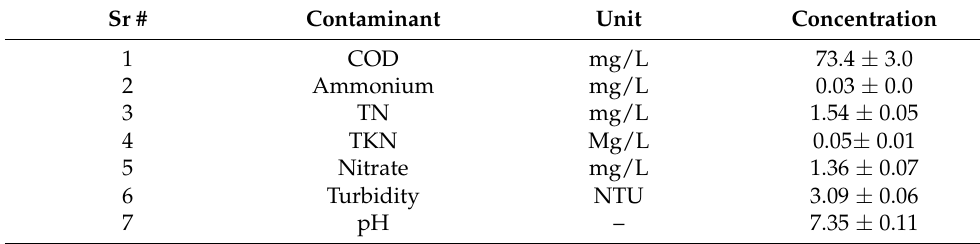
Figure 3. Influent, effluent, and percentage removal efficiency over time of ( a ) COD, ( b ) TN, ( c ) ammonium, and ( d ) turbidity. Table 2. Properties of effluent